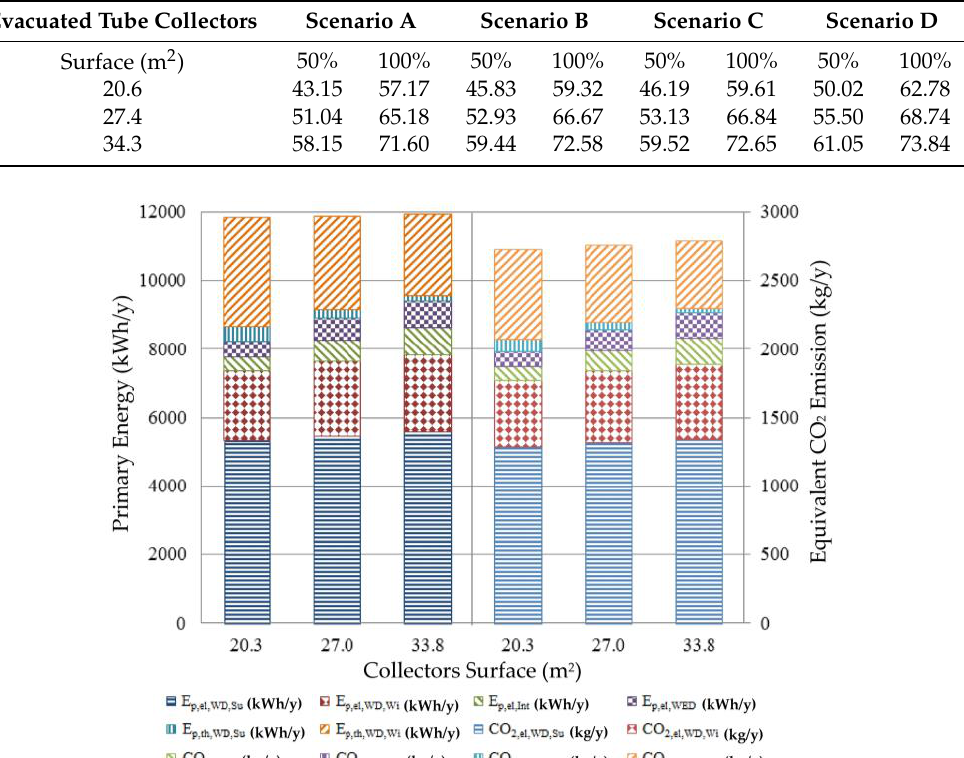
Table 6. Best PES with evacuated tube collectors and solar thermal energy recovery of 50% and 100%.